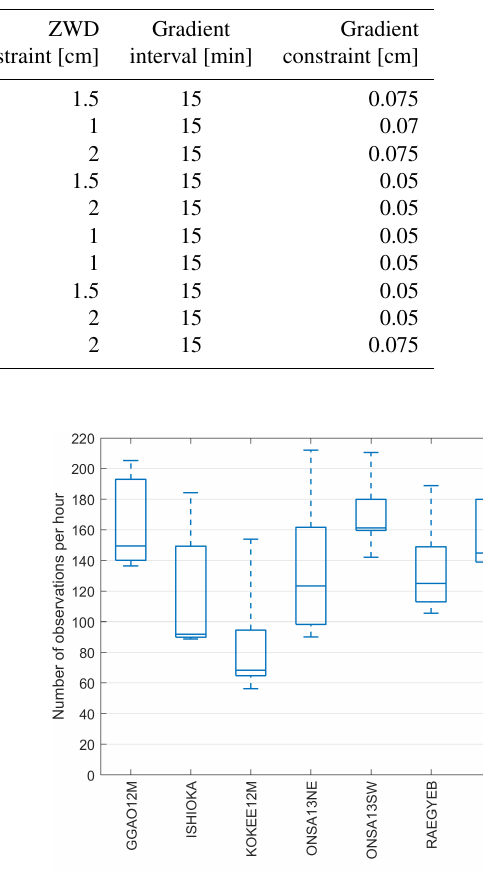
Figure 4. Number of observations per hour for the VGOS stations as boxplots. Boxplot for all stations for the R1 and R4 sessions of 2019 added for